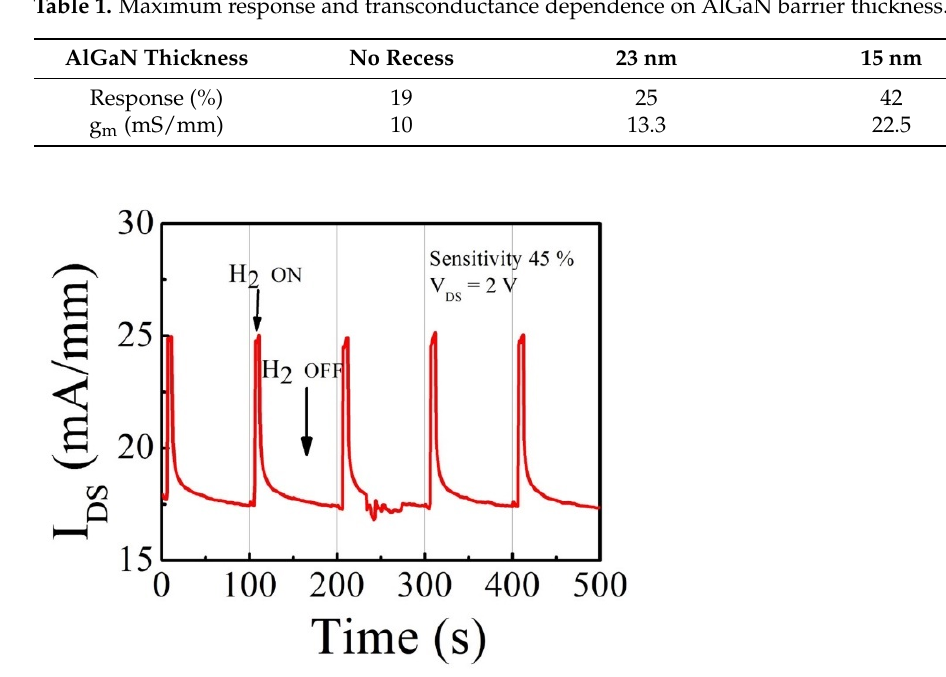
Figure 6. Transient-response characteristics to hydrogen of a 3-terminal standard sensor with 15 nm-AlGaN measured with V GS = 0 V, V DS = 2 V at 200 °C—one cycle included 4% hydrogen in